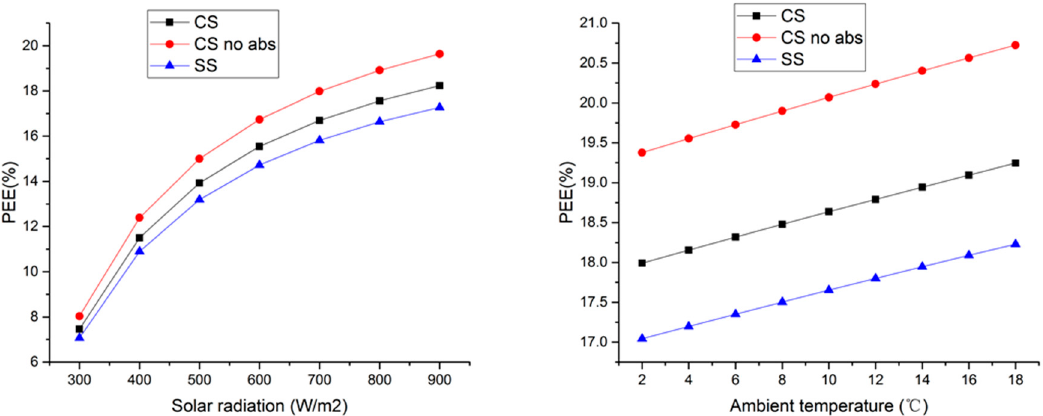
Figure 10. PEE of the systems as a function of solar radiation and ambient temperature.